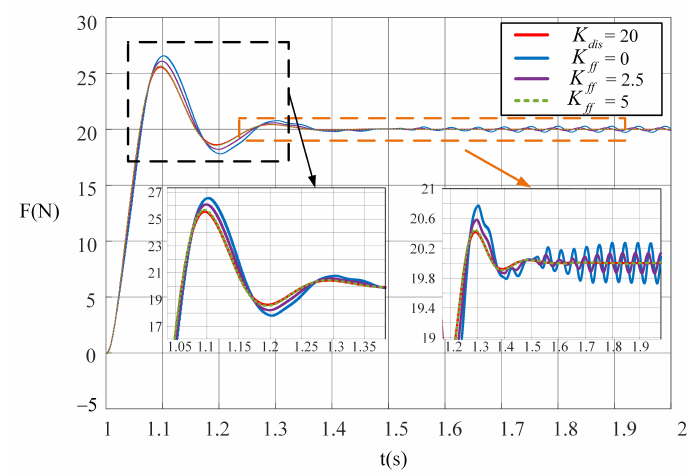
Figure 13. Force step response of the DFF-FOIC with dynamic